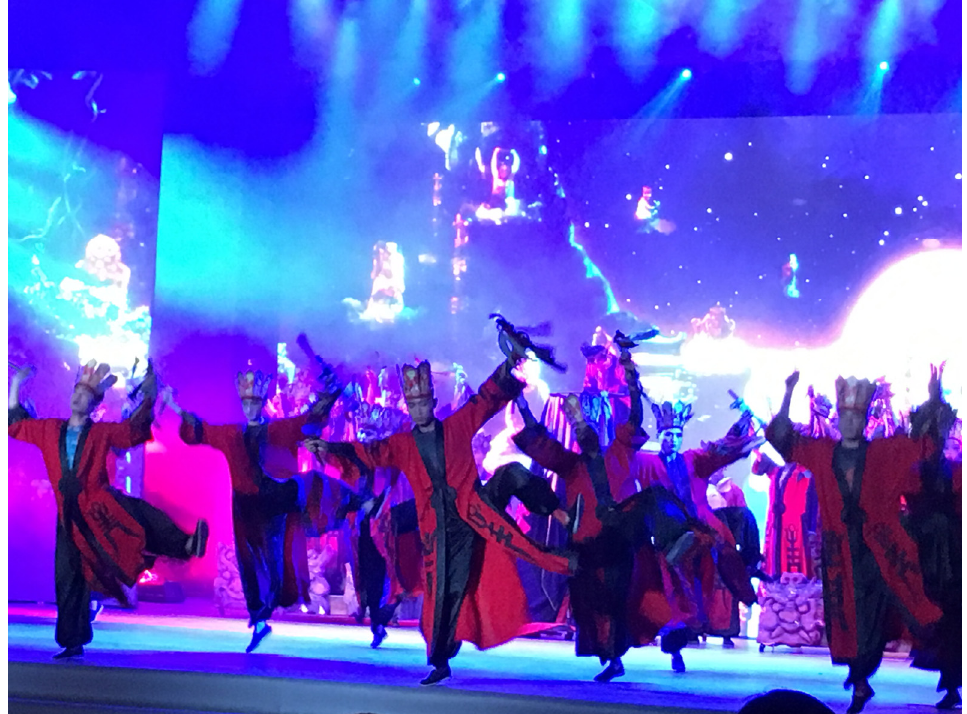
Figure 1. A theatricalized performance depicting Badai. Created and presented by actors for tourists and without any spiritual or ritual significance. Shanjiang Miao Tourist Village in Fenghuang County. 2018. (Photo: Thomas Riccio).